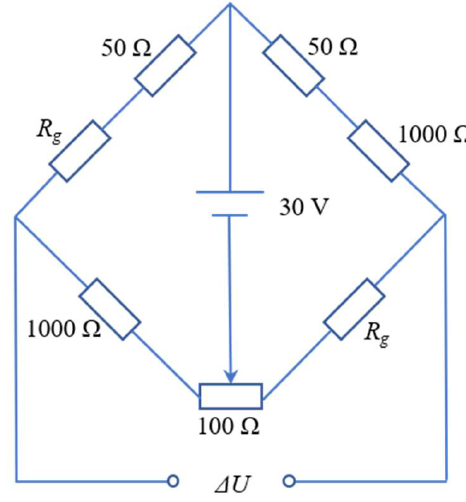
Figure 2. Diagram of the SHPB system used in this work.